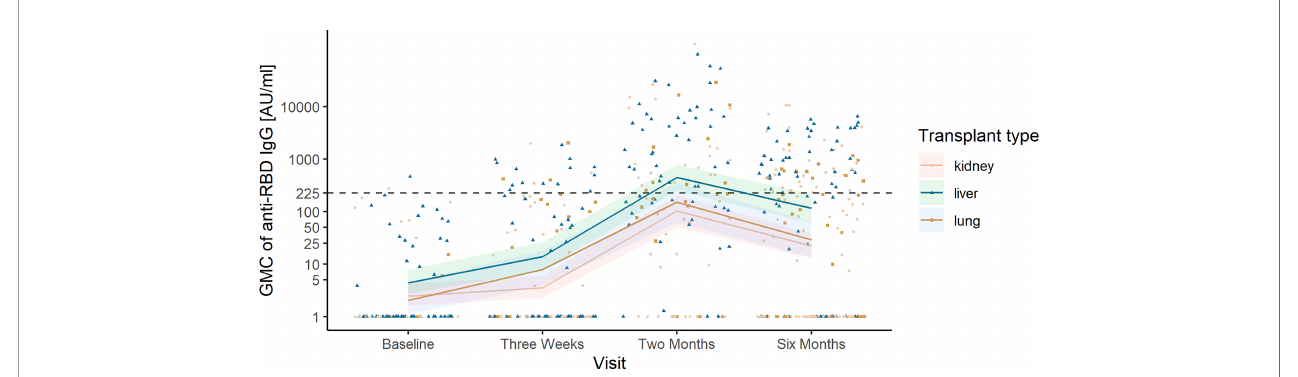
FIGURE 4 | Observed anti-receptor-binding domain (RBD) immunoglobulin G (IgG) concentrations and predicted geometric mean concentration (GMC) of anti-RBD in liver, kidney, and lung transplant recipients. Development in predicted GMC of anti-RBD IgG represented in AU/ml plotted on top of the observed individual concentration of anti-RBD IgG at each sample time in liver (green/triangle), kidney (yellow/circle), and lung transplant recipients (brown/square). The dashed horizontal line indicates the minimum threshold for positive humoral